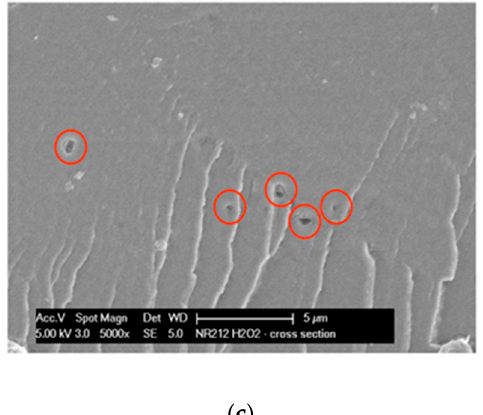
Figure 1. Comparison of membranes cross-section scanning electron microscopic (SEM) images: ( a ) N-AR, ( b ) N-HNO3, ( c ) N-H2O2.